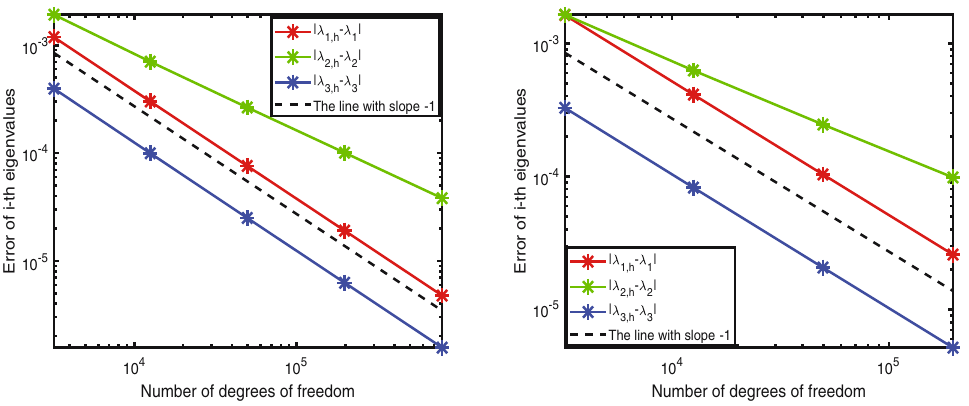
Figure 1: Error curves of the fi rst three eigenvalues on uniform meshes for ( 2.1 ) – ( 2.2 ) on the L - shaped domain ( the left: k = 1, n ( x ) = 4, the right: k = 1, n ( x ) = 4 + 4 i ) .